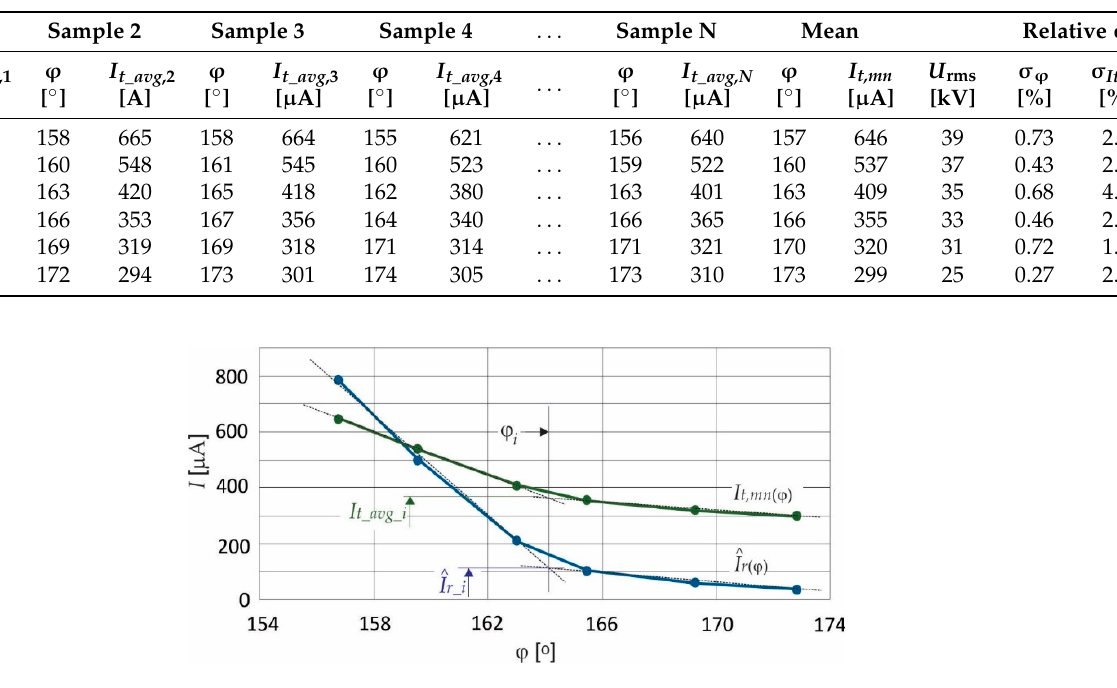
Figure 5. Static characteristics of ˆ I r = ˆ I r ( ϕ ) and I t , mn = I t , mn ( ϕ )